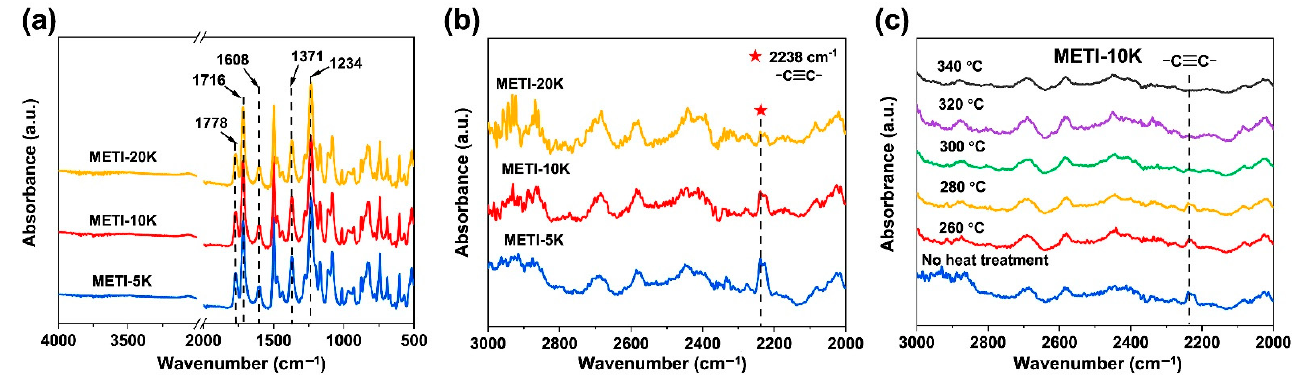
Figure 5. FTIR spectra of METI NFMs. ( a ) spectra of pristine METI NFMs; ( b ) spectra in the wavenumber range of 2000 − 3000 cm − 1 ; ( c ) spectra of METI-10K treated at different temperatures.